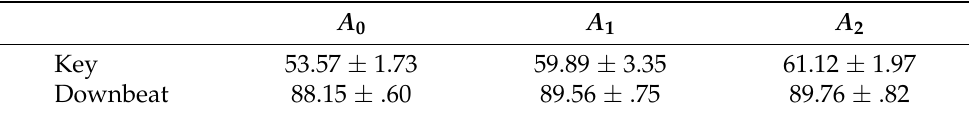
Table 6. Mean prediction accuracy and standard deviation on the 5-fold for the learning of the key and the downbeat information on A 0 , A 1 and A 2 (prediction performed on a symbolic sequence of eight